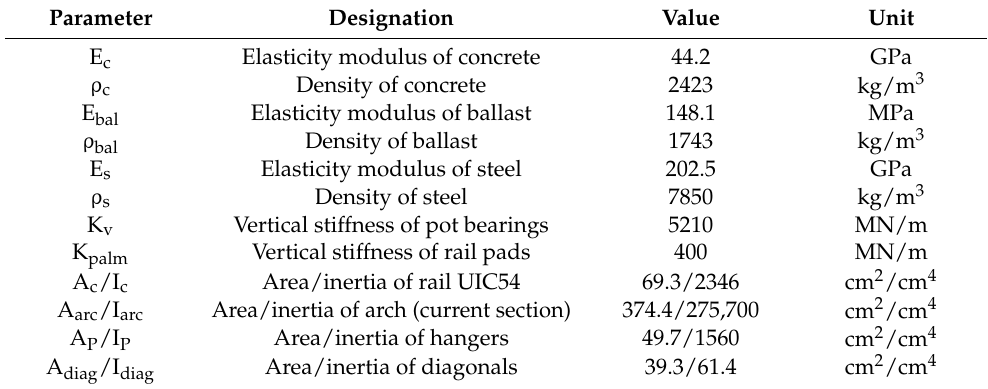
Table 1. Characterization of the main parameters of the numerical model of S ã o Lourenço bridge.